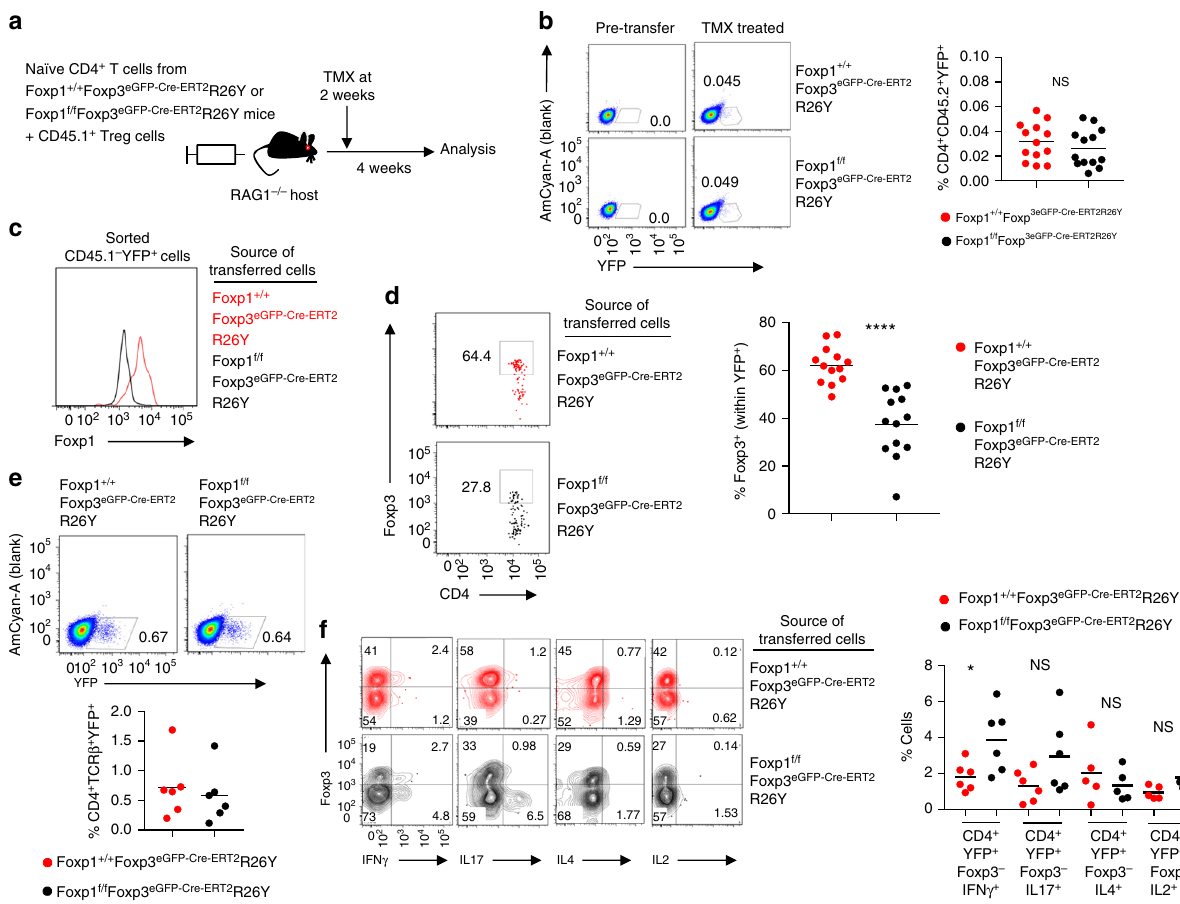
Fig. 2 In vivo differentiated iTreg cells fail to retain stability in the absence of Foxp1. a Experimental scheme. Double FACS-sorted >99% pure Tnv cells from control Foxp1 + / + Foxp3 eGFP-Cre-ERT2R26Y or Foxp1 f/f Foxp3 eGFP-Cre-ERT2R26Y mice were co-transferred with Treg cells sorted from CD45.1 + Foxp3 GFP mice